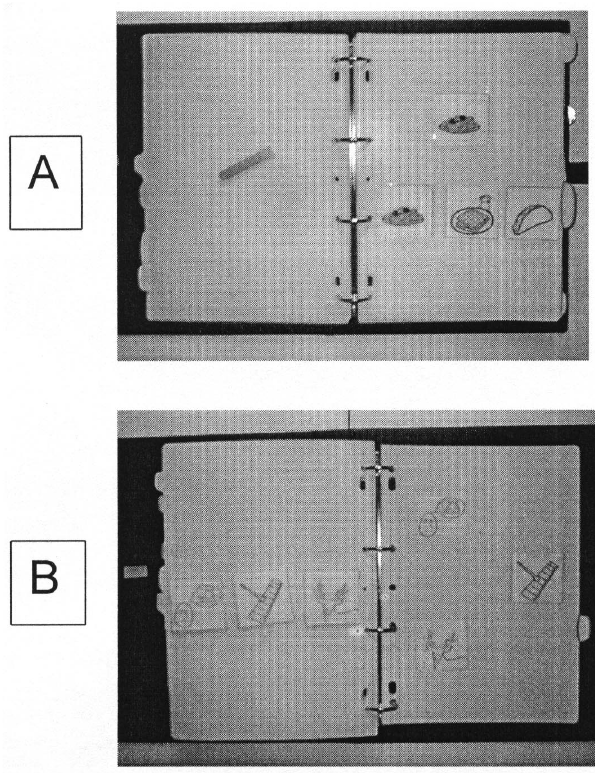
Figura 1 . Exemplo de tarefa de emparelhamento por identidade com os arranjos típico (A) e adaptado (B). A. Divisória